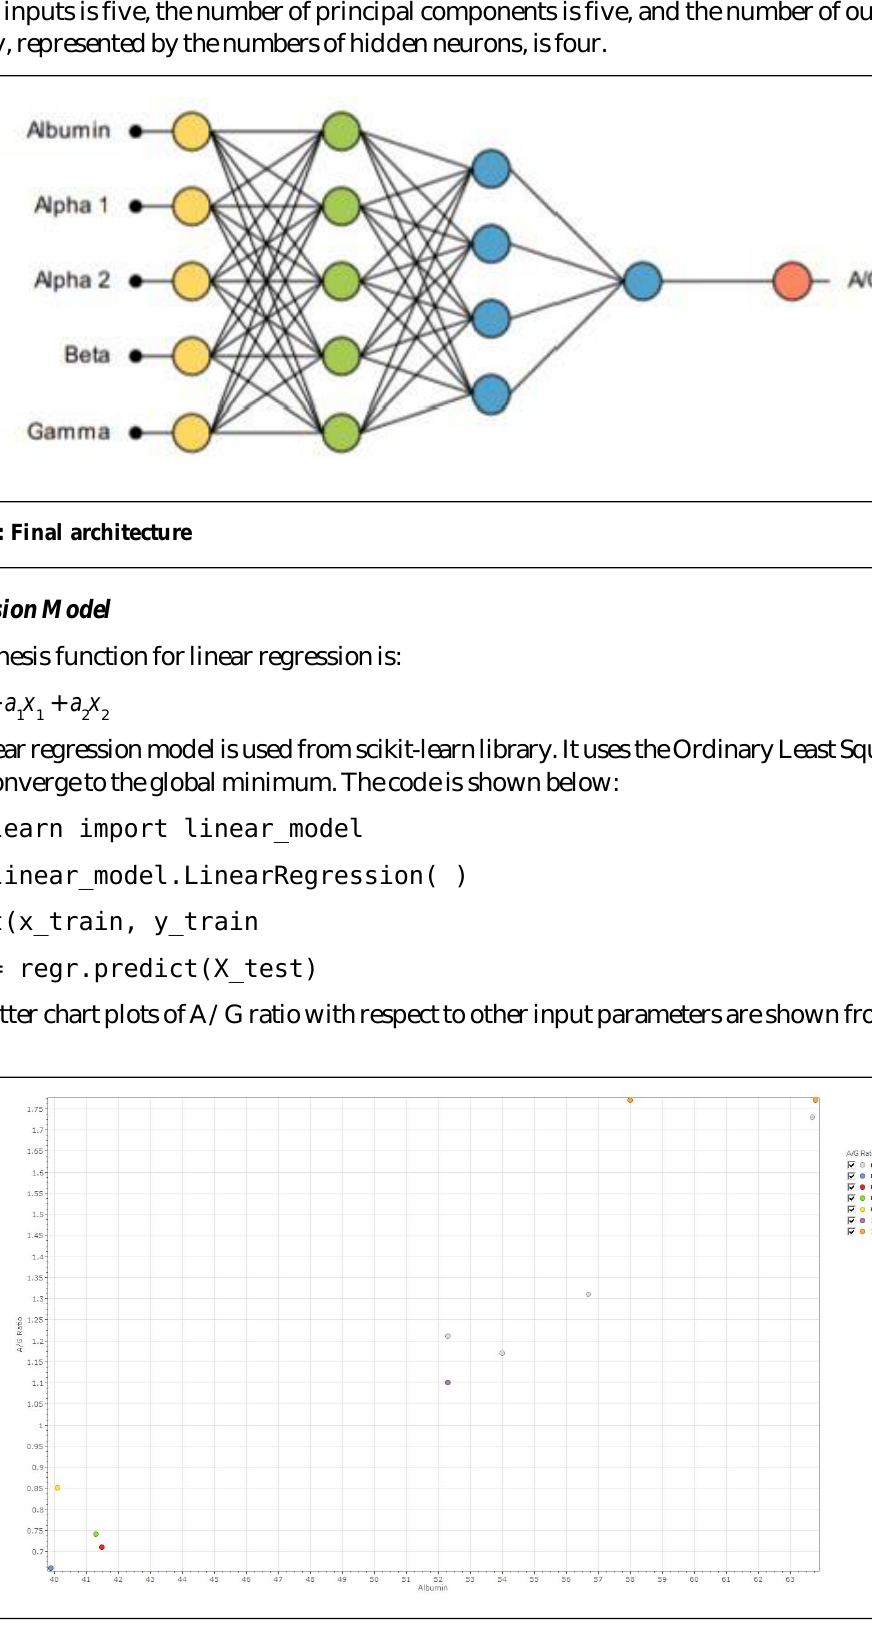
Figure 5: Scatter plot of A/G ratio with respect to